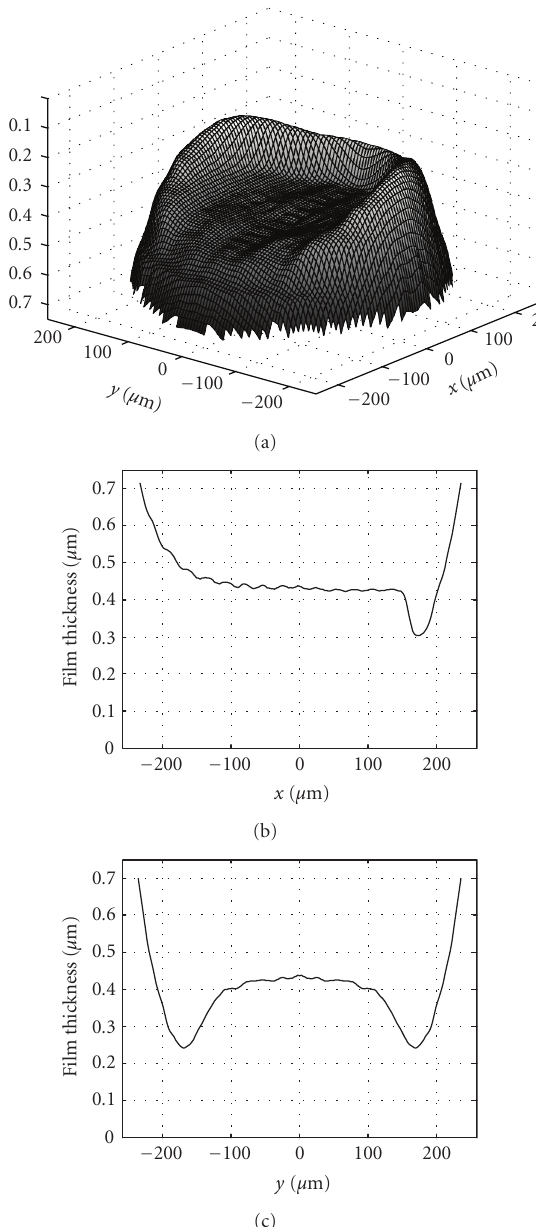
Figure 10: Final results: 3D surface plot of the film thickness (a) and film thickness in midplane sections along the x axis (entrain- ing direction) (b) and the y axis (perpendicular to the entraining direction)